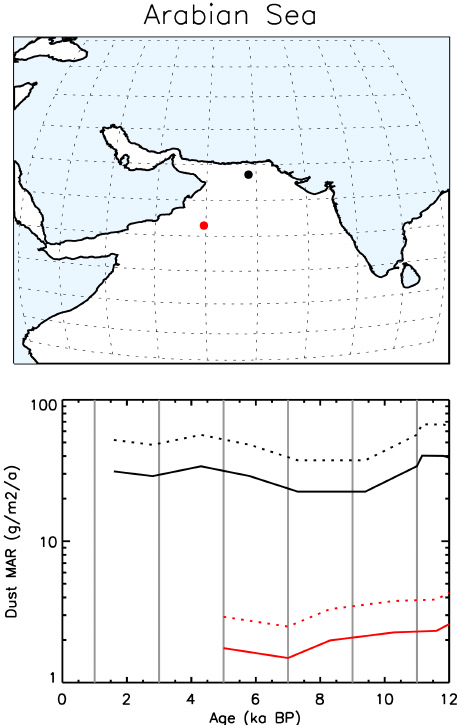
Figure 7. Same as Fig. 6 but for the Arabian Sea